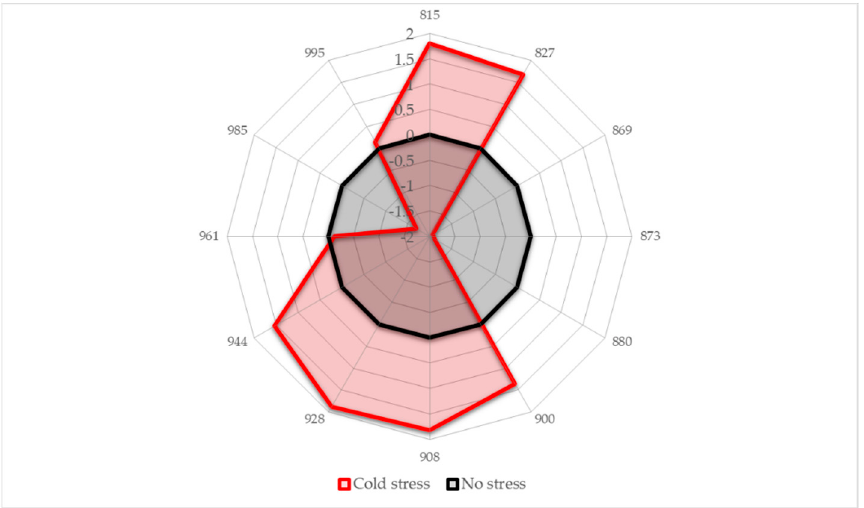
Figure 5. Aquagrams showing differences in the average spectral pattern of all soybean cultivars in the conditions of no stress and during cold stress.